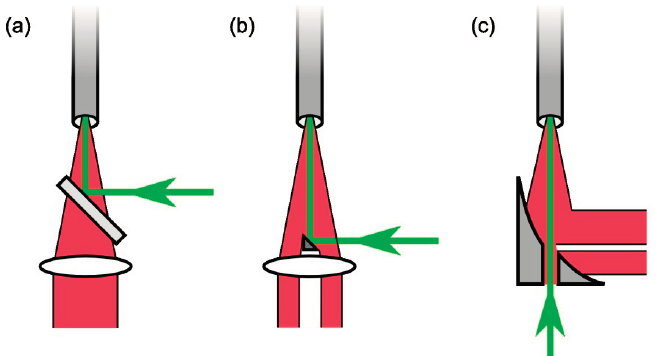
Figure 3. Comparison of laser (green) and Raman (red) light paths when using ( a ) a dichroic beam splitter; ( b ) a pick-off mirror; or ( c ) an off-axis parabolic mirror with central hole for light